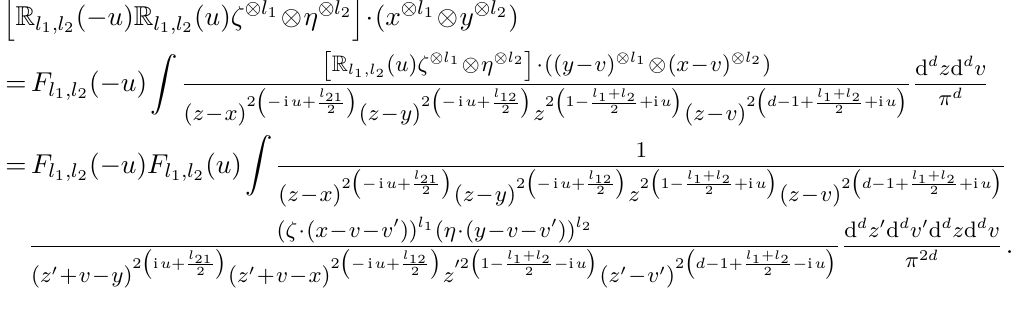
and in the expression for the Basso-Dixon diagram